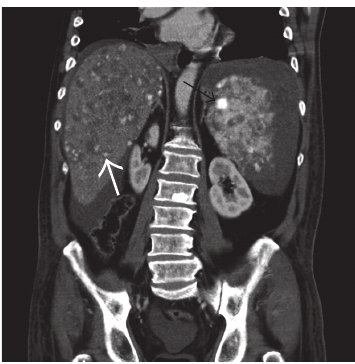
Figure 3: Venous phase: multiple hepatic (white arrow) and splenic (black arrow) lesions.